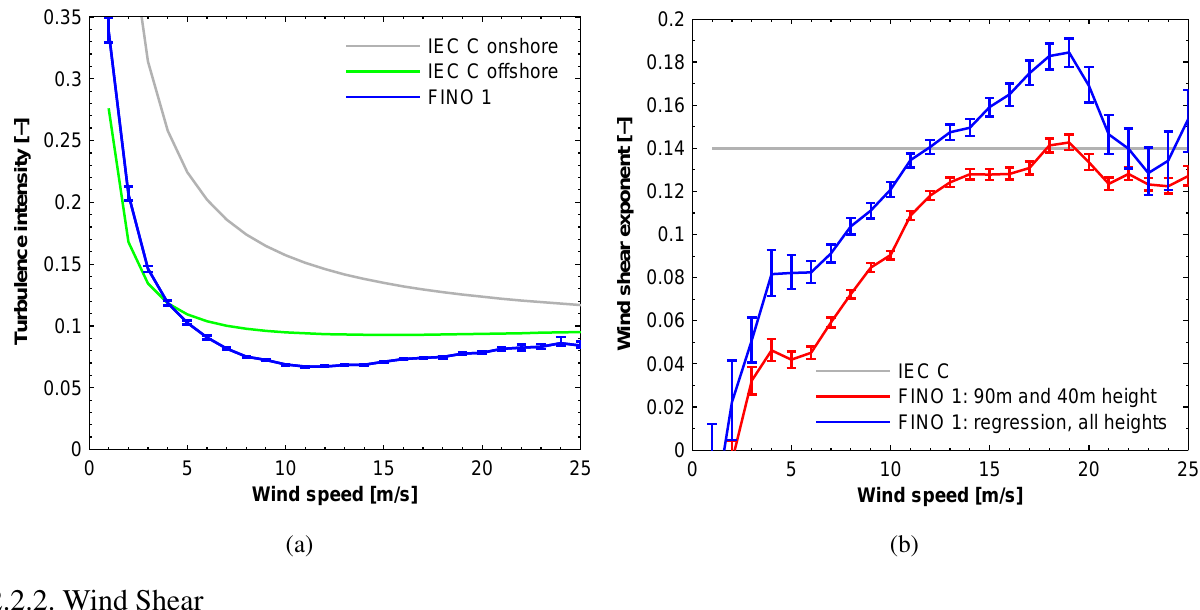
Figure 4. The 90th percentile of the measured turbulence intensity and mean value of the measured wind shear exponent depending on wind speed and in comparison to the IEC standard 61400-3 [1]. ( a ) Turbulence intensity; ( b ) Wind shear